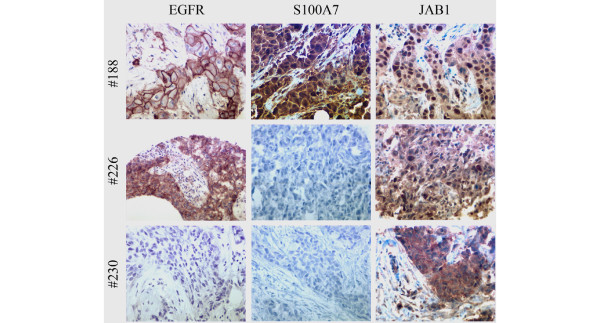
Jab1 nuclear expression correlates with increased EGFR and S100A7 in breast tumors. EGFR, S100A7, and Jab1 were detected by immunohistochemistry in breast tumors represented within a tissue microarray. Representative staining is shown for all three markers and in three separate tumors. Tumor #188 (top row) shows high nuclear Jab1 expression associated with high EGFR and S100A7 expression. Tumor #226 (middle row) shows intermediate nuclear and cytoplasmic Jab1 expression associated with moderate EGFR and absence of S100A7 expression. Tumor #230 (bottom row) shows low nuclear but high cytoplasmic Jab1 expression associated with the absence of EGFR or S100A7 expression. EGFR, epidermal growth factor receptor; Jab1, c-Jun activation domain-binding protein-1.